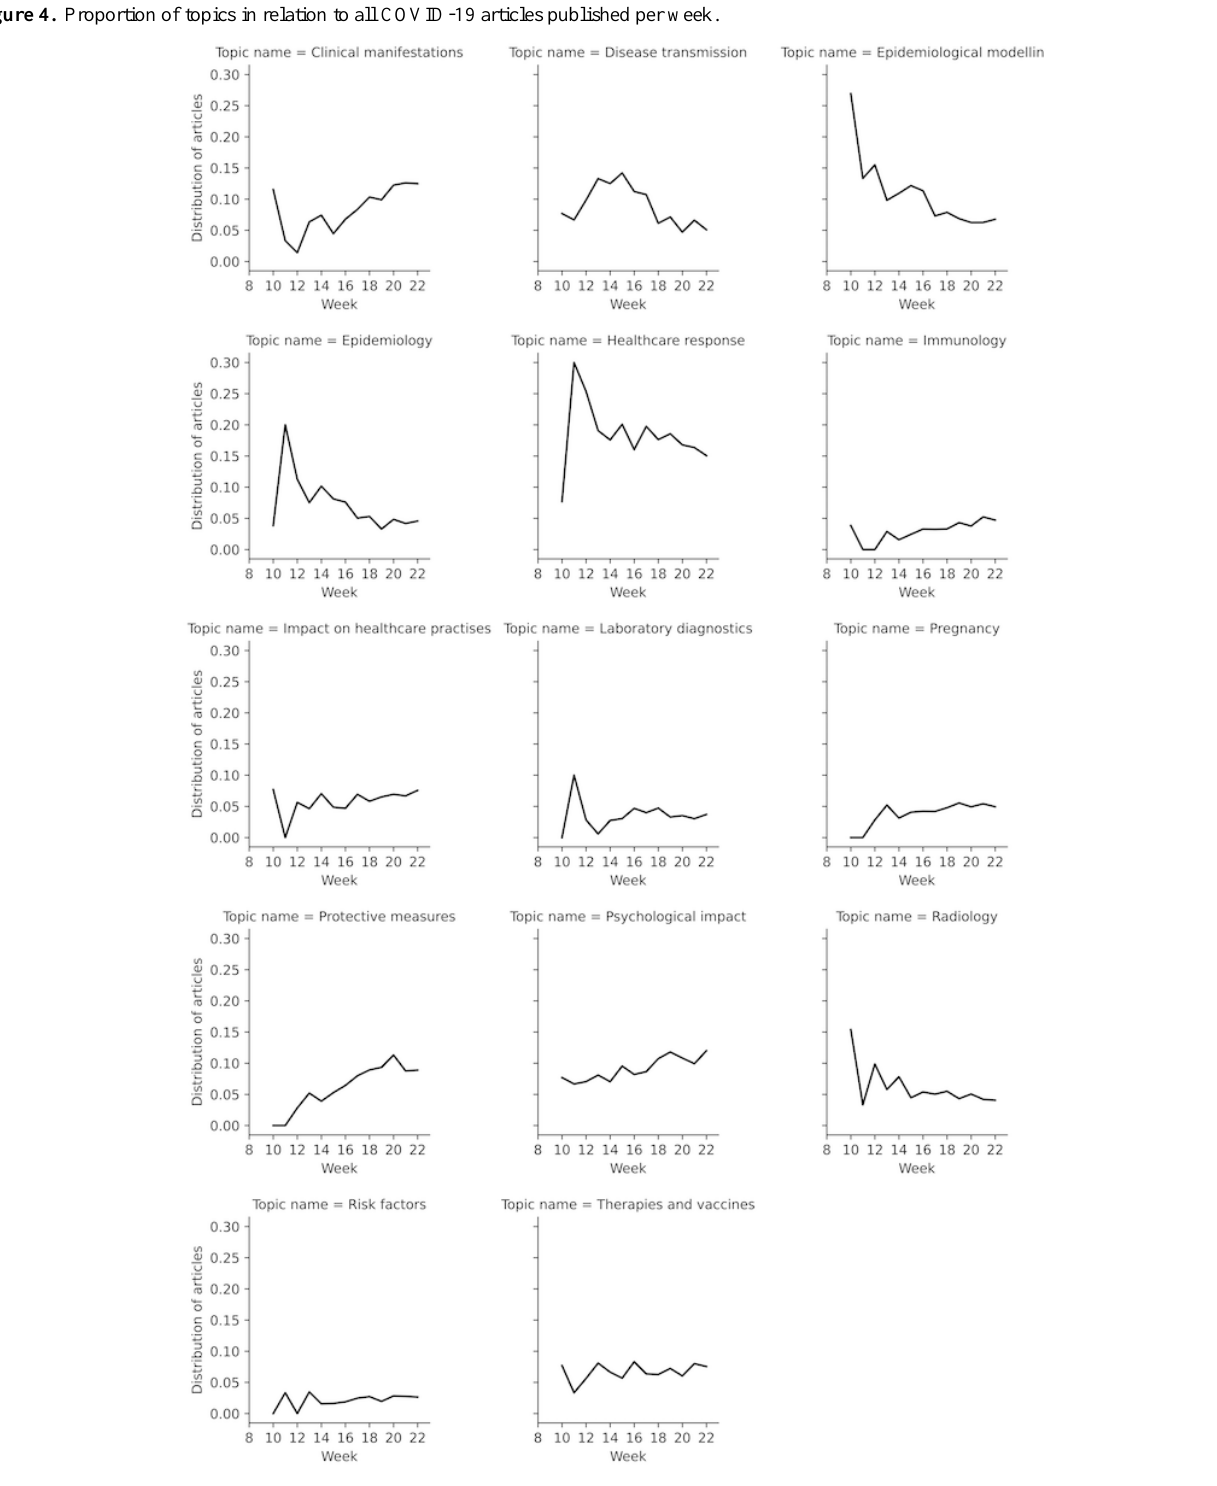
Figure 4. Proportion of topics in relation to all COVID-19 articles published per